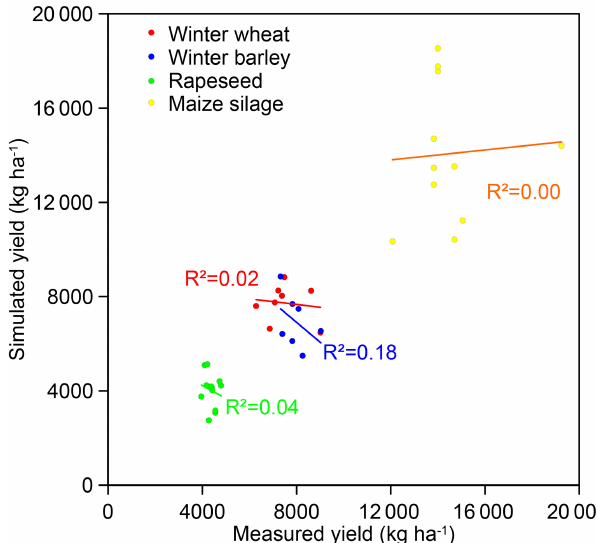
Figure 8. Crop yield and NO − -N loadings as functions of N fer- 3 tilization given as percentages. The gray lines indicate the largest difference between crop yield and NO 3 -N loadings. 100% corre- spond to the actual